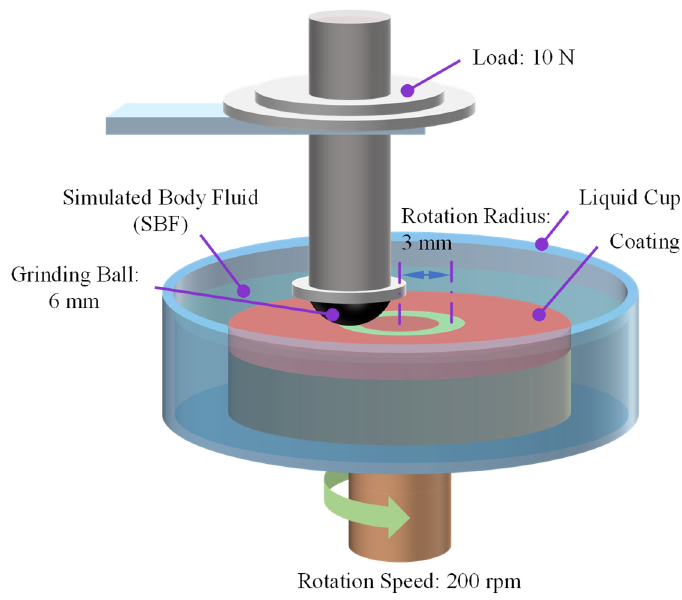
Figure 3. Schematic diagram of friction and wear test.